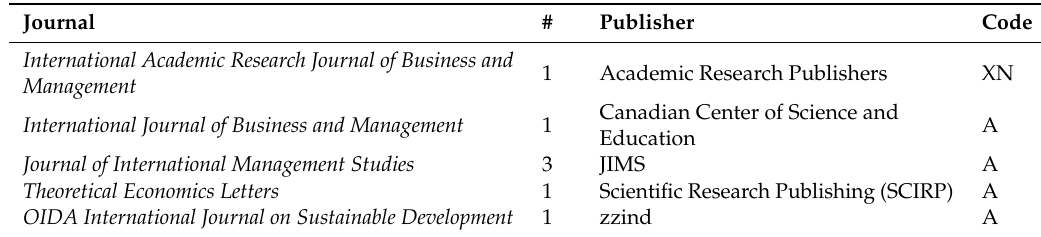
Table 5. Publications of the 27 research faculty members at a small business school in Canada listed in Crawford’s gray open access list.